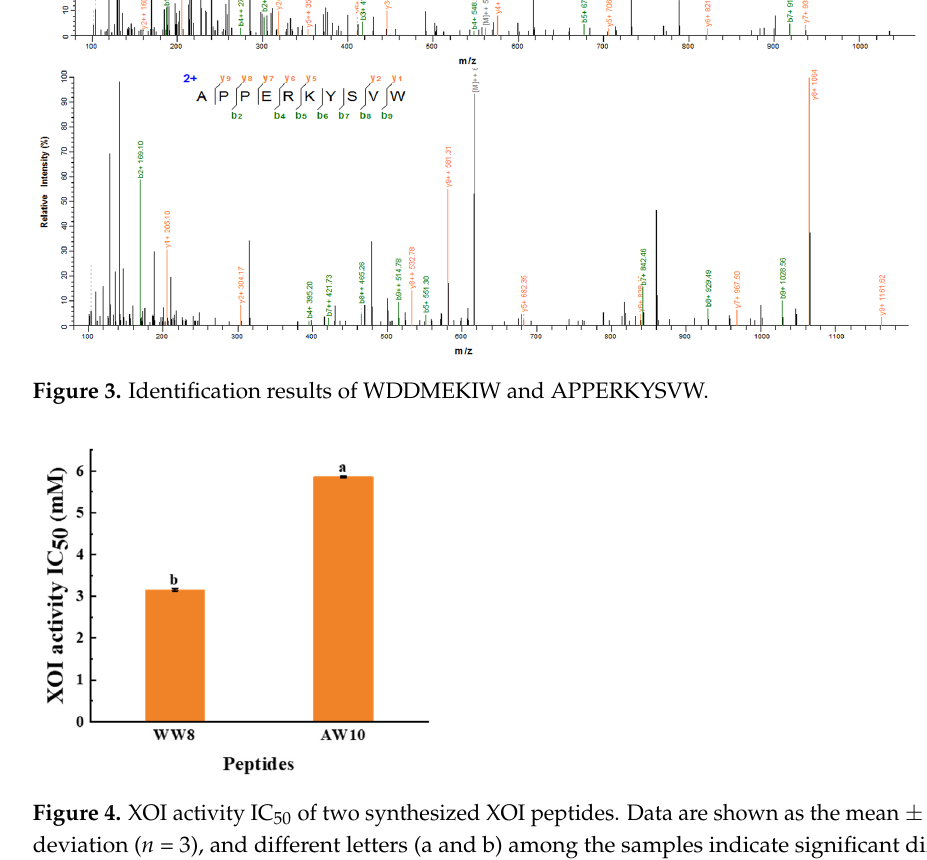
Figure 4. XOI activity IC 50 of two synthesized XOI peptides. Data are shown as the mean ± standard deviation ( n = 3), and different letters (a and b) among the samples indicate significant differences ( p < 0.05).